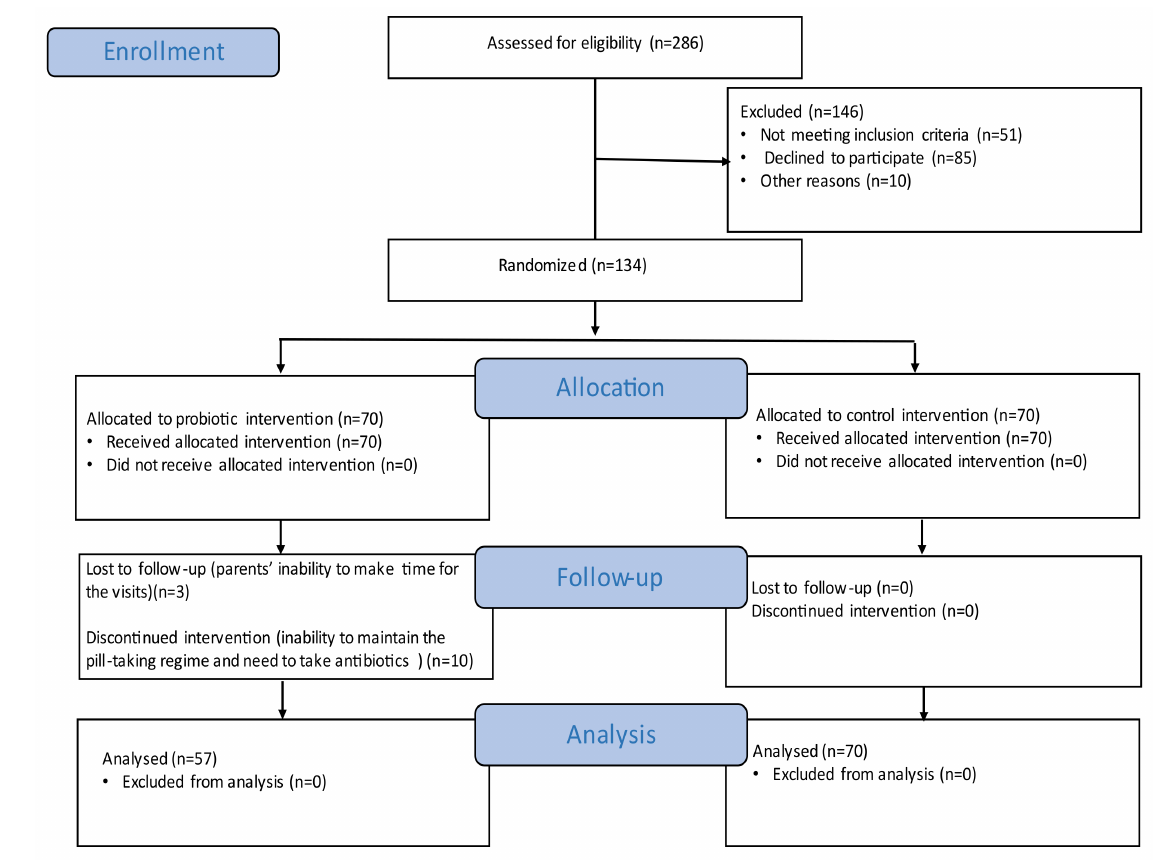
Figure 1. Research flow diagram (according to CONSORT). Table 1. Baseline characteristics of the children in the probiotic and control